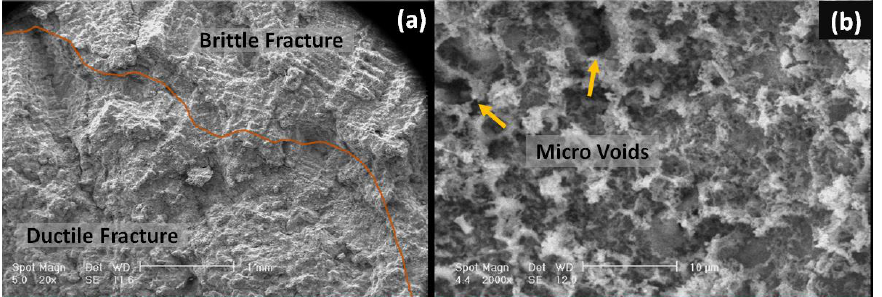
Figure 10. SEM images of fracture surface morphology of the failed tube, ( a ) final ductile and brittle fracture surfaces and ( b ) ductile fracture surface.